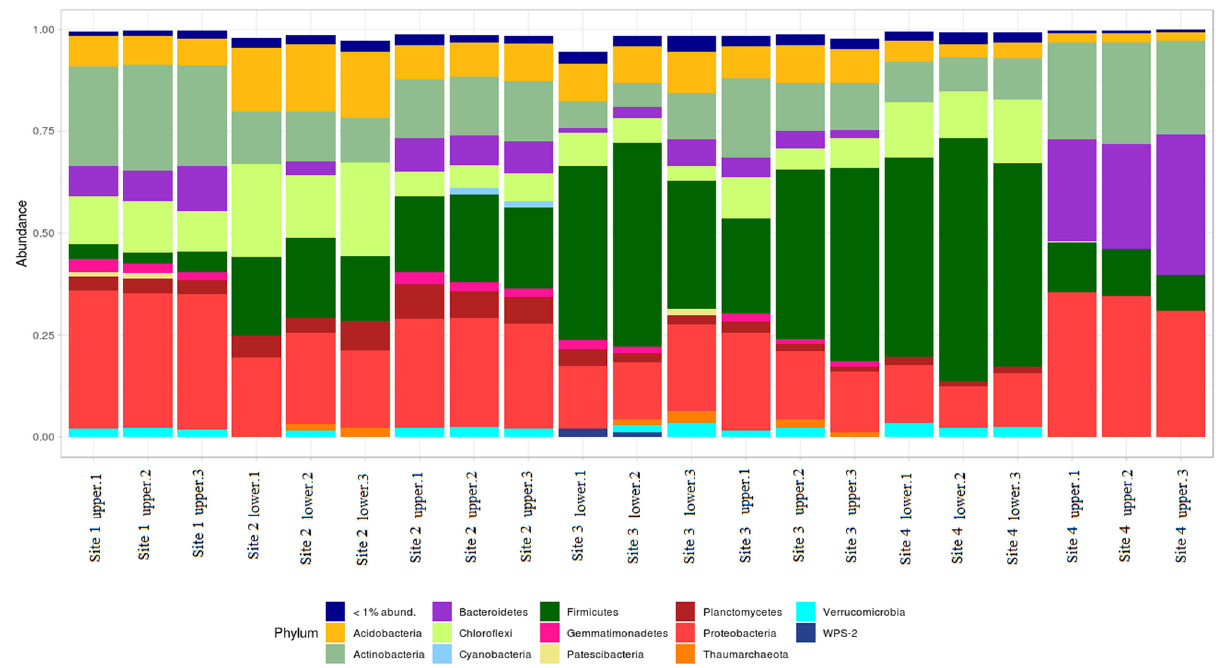
Figure 4: Taxonomic composition of soil microbiomes.